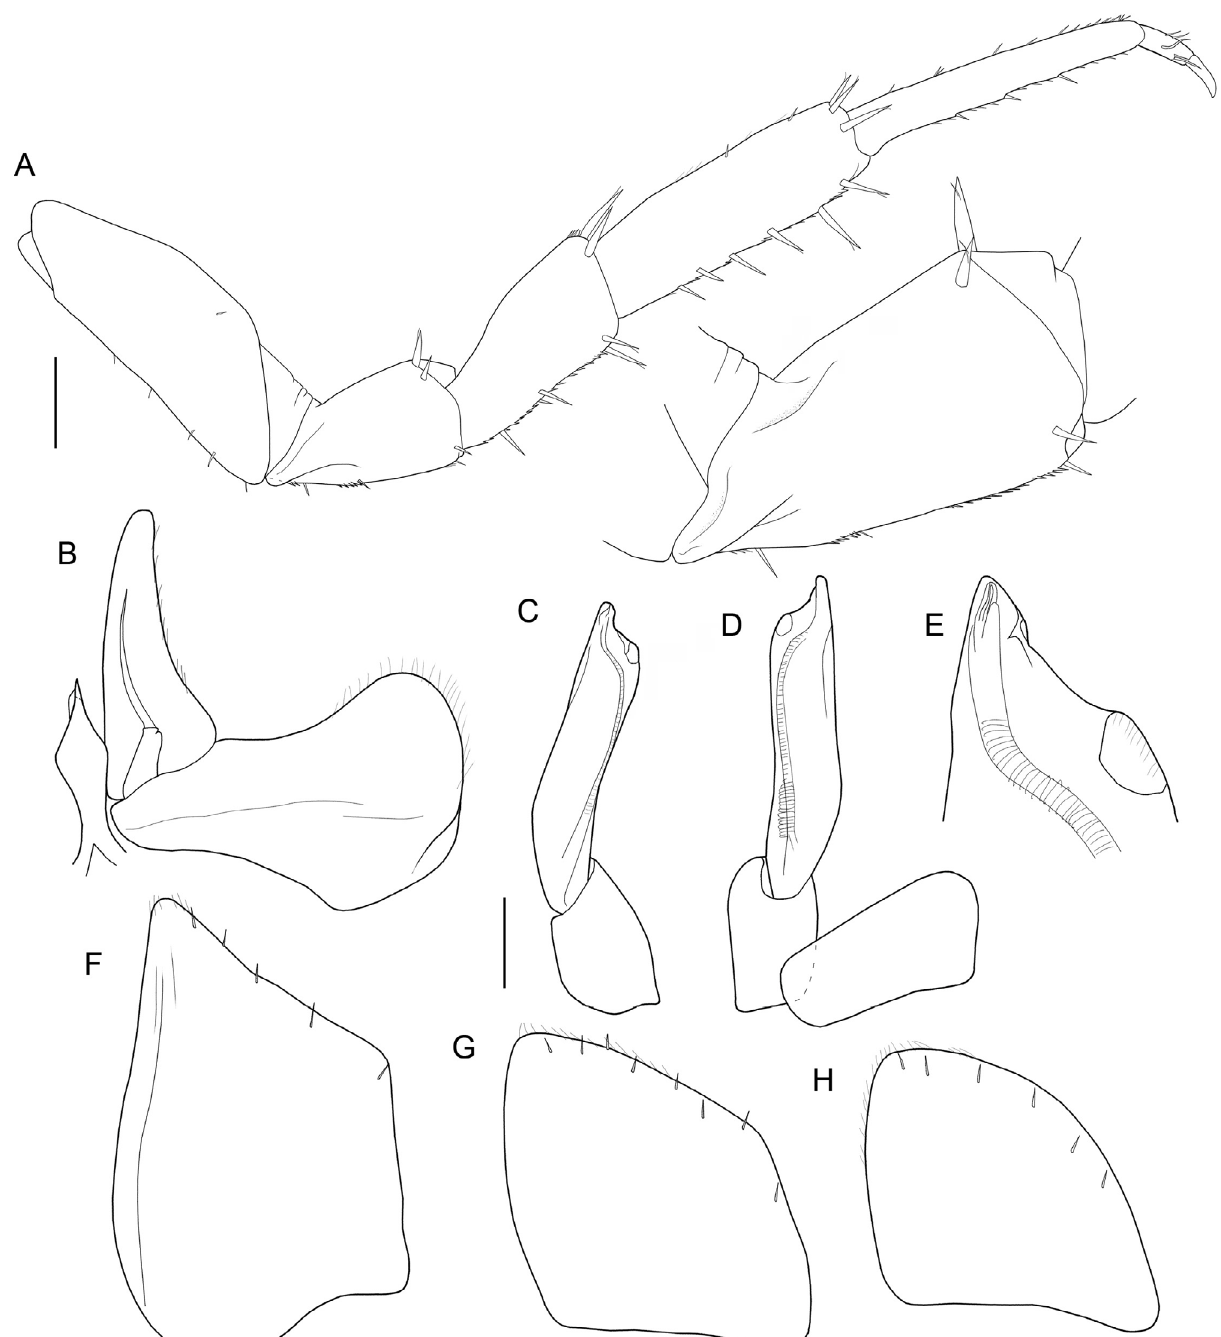
Figure 5. Spelunconiscus castroi Campos-Filho, Araujo and Taiti 2014. A : Pereopod 7 and detail of the spur-like structure on the ischium. B : pleopod 1; C – E : pleopod 2; F : pleopod 3; G : pleopod 4; H : pleopod 5. Scale bar: 0.2